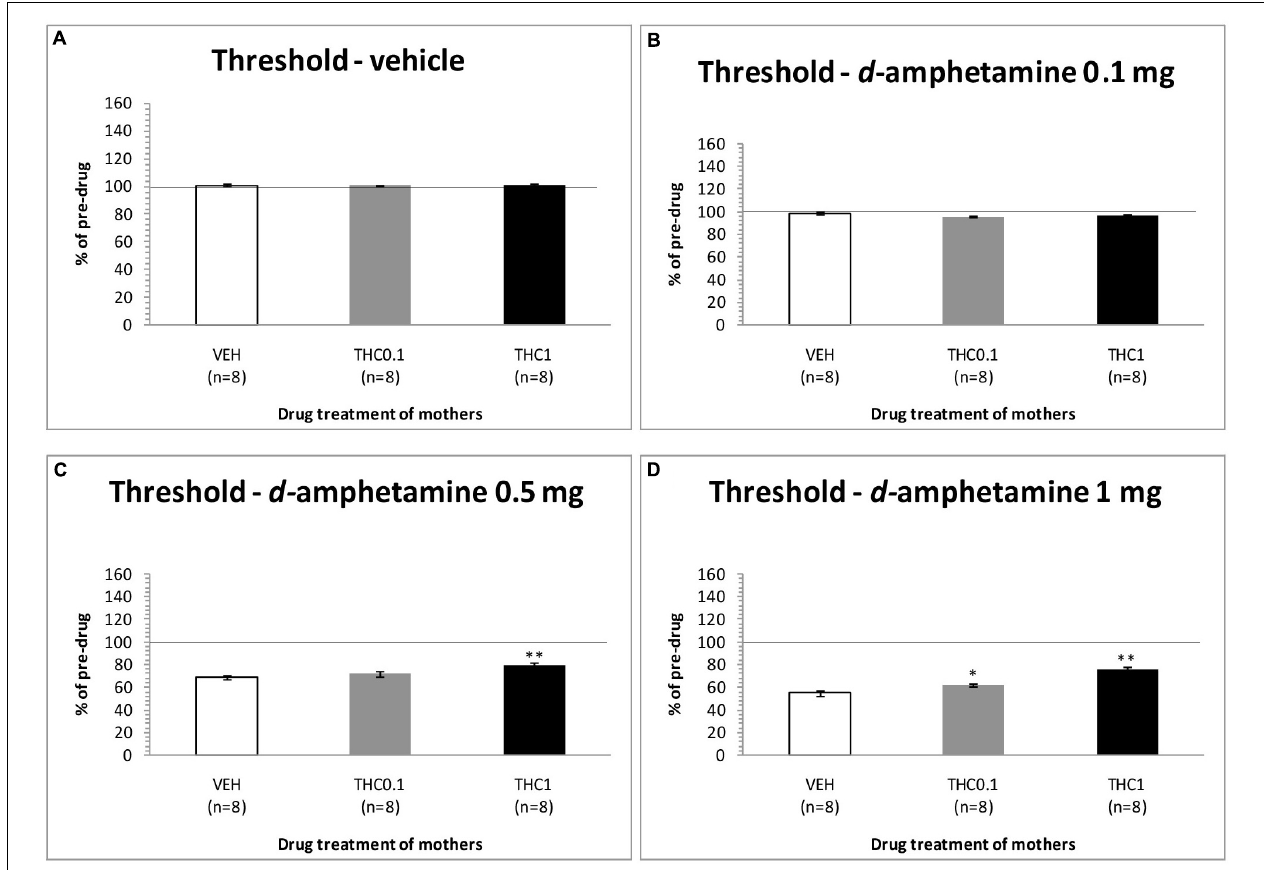
FIGURE 4 | Changes in self-stimulation threshold in F1 animals, expressed as percentage of predrug value, following acute i.p. administration of 0 mg/kg (A) , 0.1 mg/kg (B) , 0.5 mg/kg (C) , and 1 mg/kg (D) of d -amphetamine. Horizontal axes represent the three groups of F1 animals. The asterisk ( ∗ ) signifies a statistically significant effect compared to the vehicle group (F1 of F0-VEH animals), ∗ p < 0.05 and ∗∗ p < 0.01.